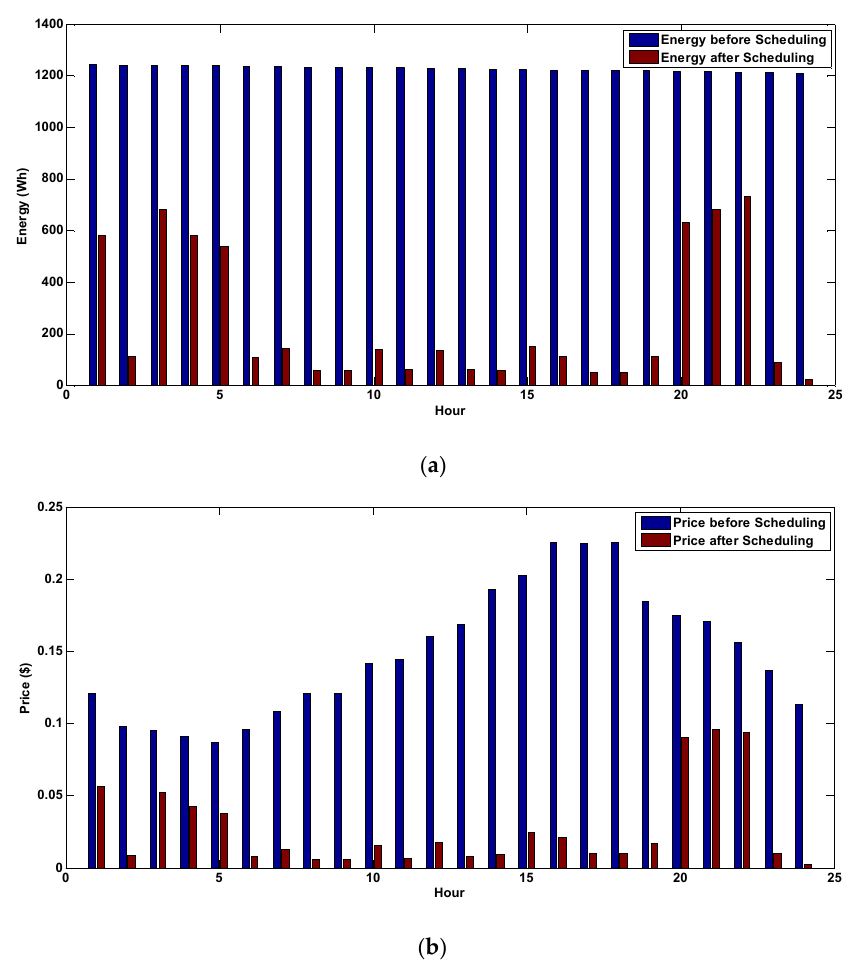
Figure 26. Total ( a ) energy consumptions and ( b ) bills without and with the use of the HEM system.